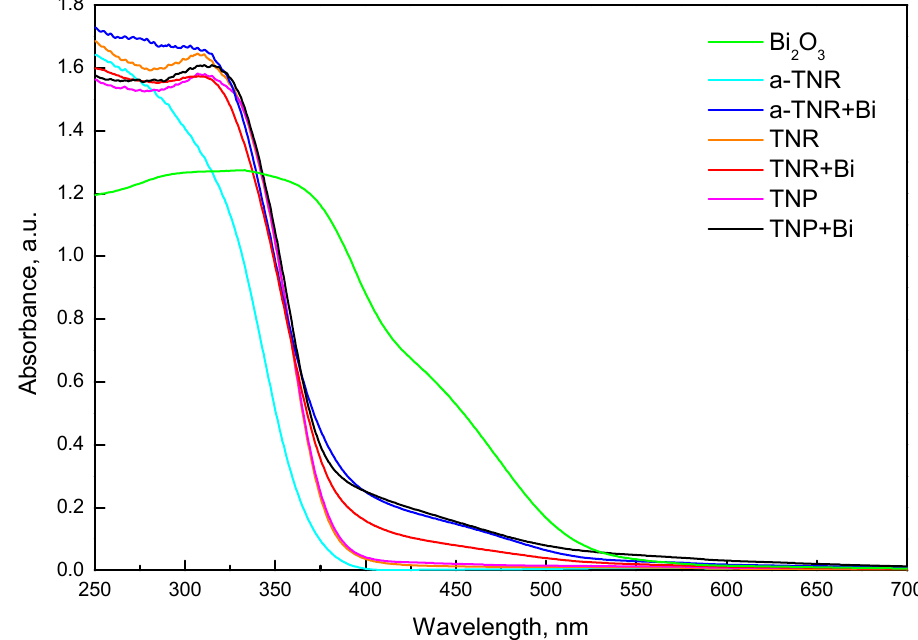
Figure 5. Spectra of UV-Vis Diffuse Reflectance (DR) measurements performed on synthesized catalysts.